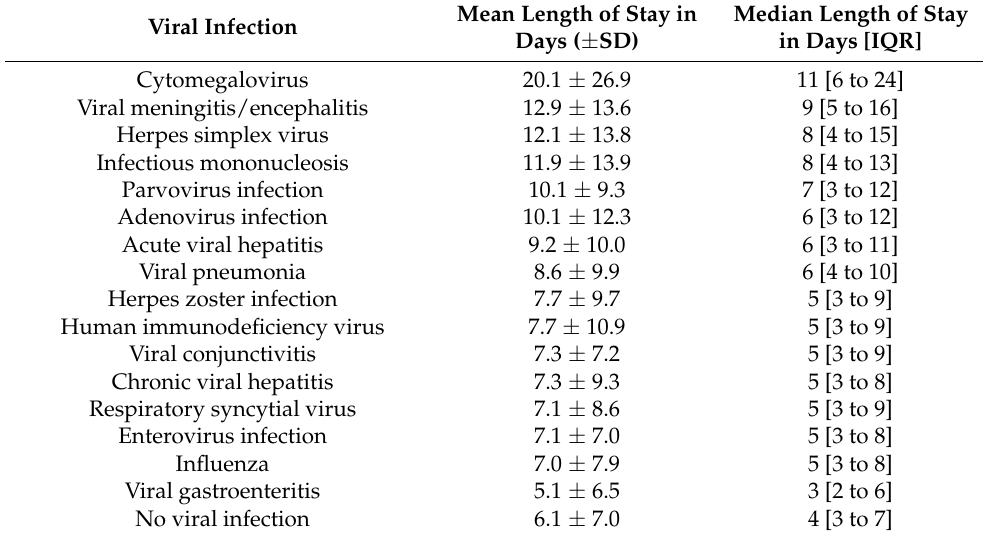
Table 2. Mean and median length of stay for records with and without viral infections with a hospital diagnosis of heart